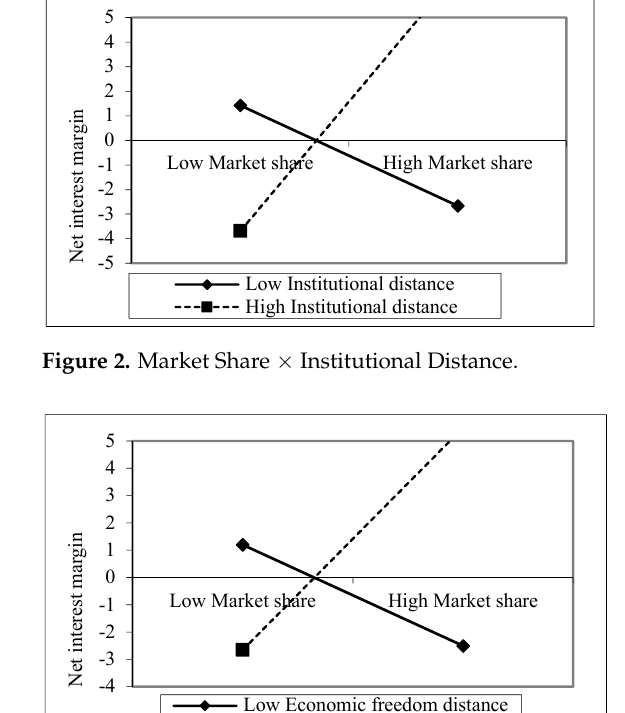
Figure 4. Market Share × Foreignness.